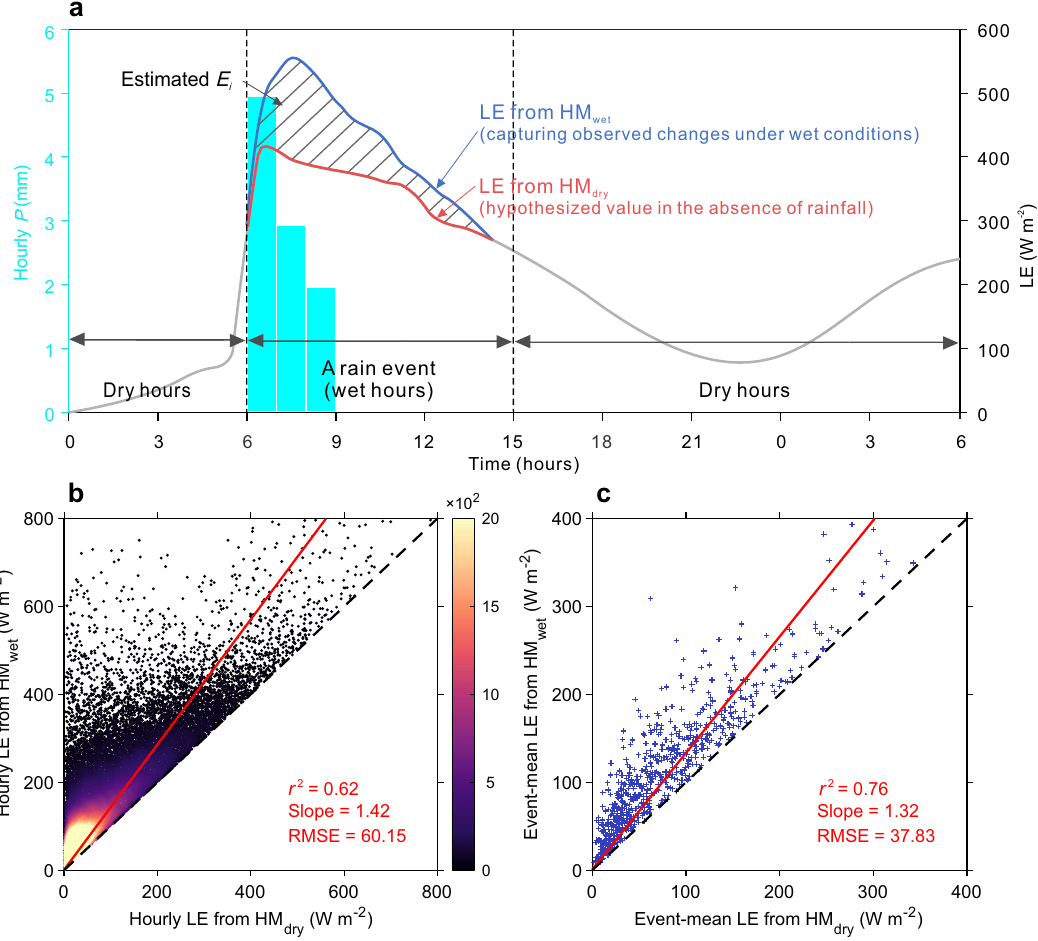
Fig. 1 | LE estimates by the hybrid models trained with wet samples (HM wet ) versusdrysamples(HM dry ).a Theconceptualframeworktoseparateinterception evaporation ( E i ) from tower-observed latent heat fl ux (LE). Cyan bars show hourly precipitation( P ).ThebluecurveshowstheresponseofLEsimulatedbyHM wet with accounting for rainfall occurrence, and red curve shows the hypothesized LE that wouldoccurintheabsenceofrainfallbasedonHM dry .Thedashedarearepresents thedifferencebetweenthetwoLEestimates,whichisusedasanestimateof E i fl ux